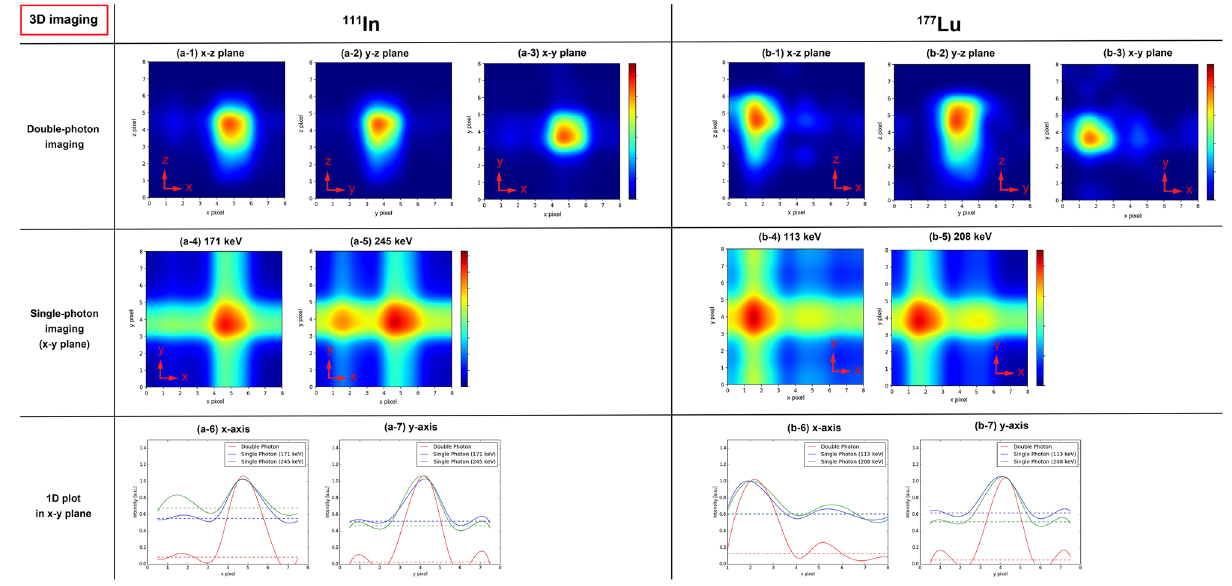
Figure 3. 3D imaging results for 111 In and 177 Lu in the microtubes. ( a-1 ) 2D slice images of 111 In by double- photon imaging in the x – z plane ( y -slice = 4). ( a-2 ) y – z plane ( x -slice = 3). ( a-3 ) x – y plane ( z -slice = 4). ( a-4 ) 2D slice images of 111 In by 171 keV single-photon imaging in the x – z plane ( y -slice = 4). ( a-5 ) 2D slice images of 111 In by 245 keV single-photon imaging in the x – z plane ( y -slice = 4). ( a-6 ) 1D slice on the x -axis of the x – y plane ( y -pixel = 4). ( a-7 ) 1D plot in the y -axis of the x – y plane ( x -pixel = 5). The dot lines denote the background value. ( b-1 ) 2D slice images of 177 Lu by double-photon imaging in the x – z plane ( y -slice = 4). ( b-2 ) y – z plane ( x -slice = 3). ( b-3 ) x – y plane ( z -slice = 4). ( b-4 ) 2D slice images of 177 Lu by 113 keV single-photon imaging in the x – z plane ( y -slice = 4). ( b-5 ) 2D slice images of 177 Lu by 208 keV single-photon imaging in the x – z plane ( y -slice = 4). ( b-6 ) 1D plot in the x -axis of the x – y plane ( y pixel = 4). ( b-7 ) 1D slice on the y -axis of the x – y plane ( x -pixel = 1). The dot lines denote the background value.